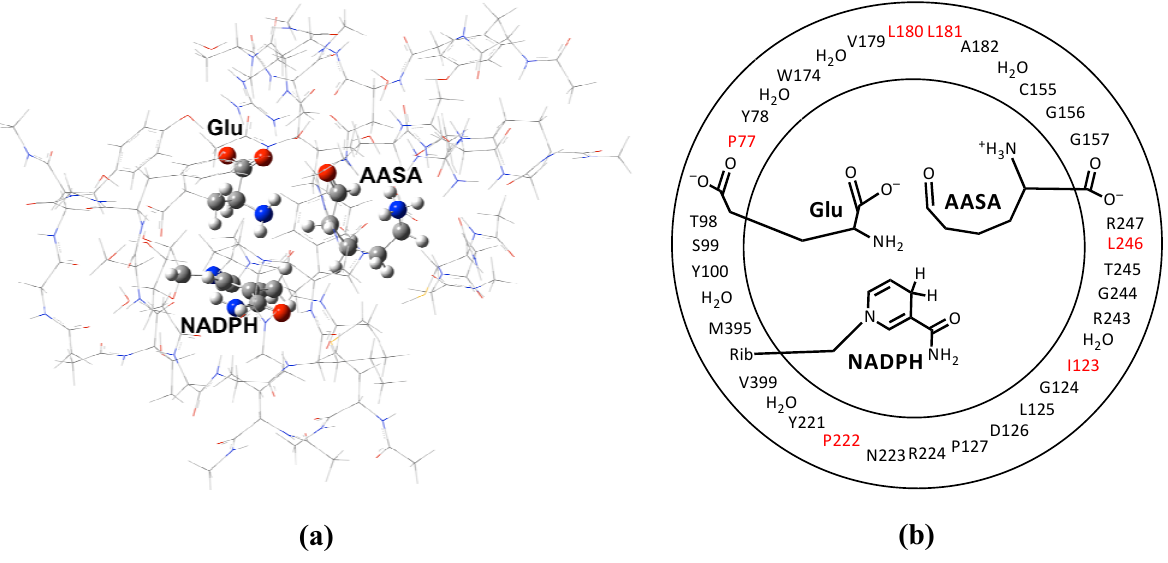
Figure 1. (a) The X-ray crystal structure (PDB ID: 1E5Q)-derived QM/MM model used to investigate the catalytic mechanism of saccharopine reductase. (b) Schematic representation of the QM/MM model: groups in the inner and outer circles have been modelled at the HF/6-31G(d) and AMBER94 levels of theory, respectively. Note, residues, waters and functional groups in black have been included in the model in their entirety, while residues in red have only had their peptide backbone